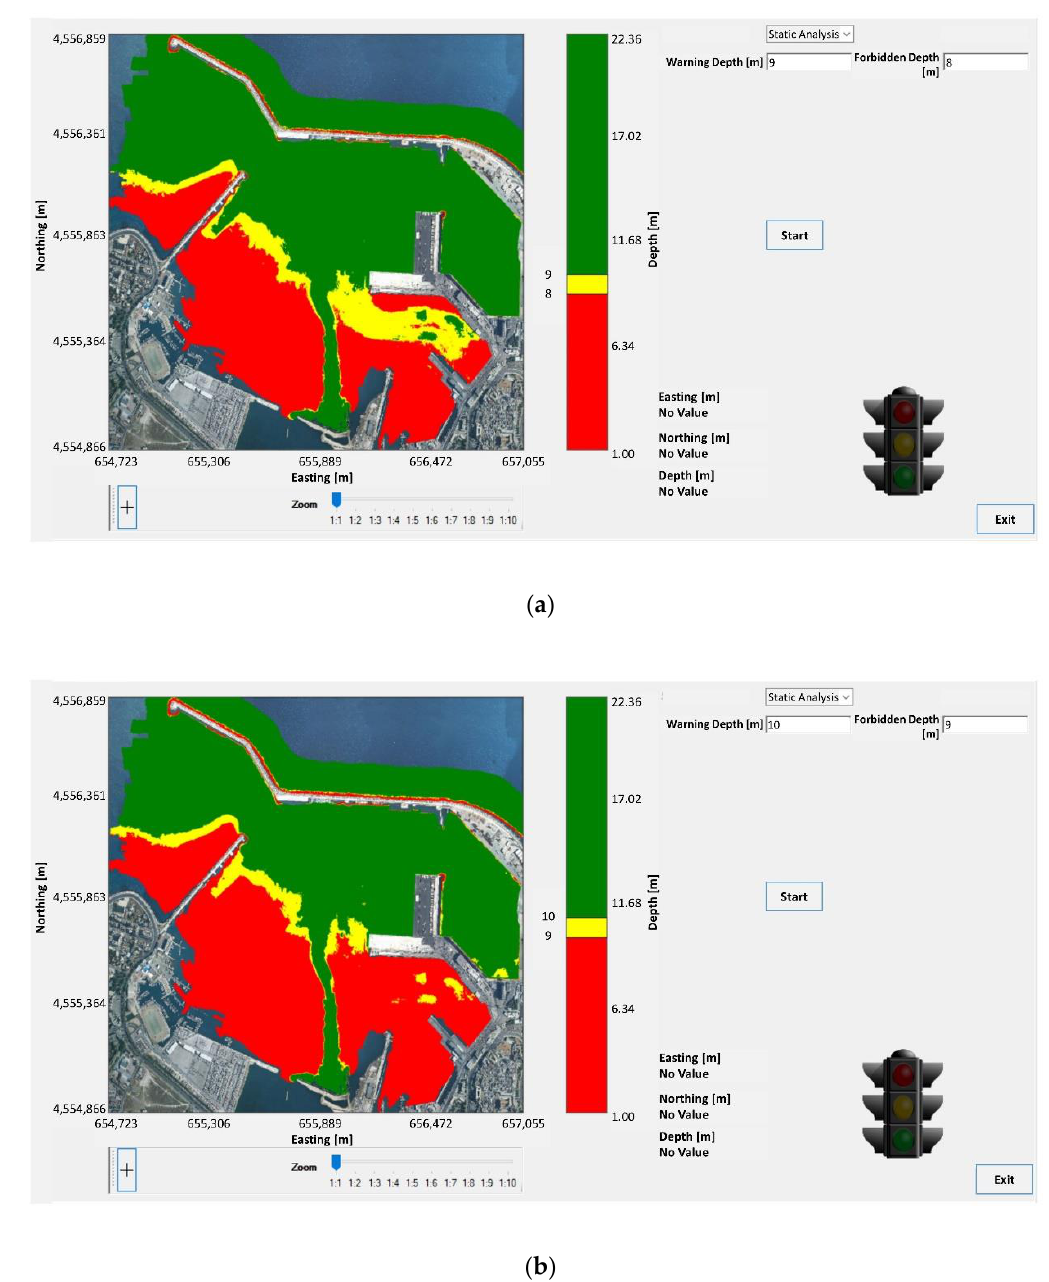
Figure 4. Virtual traffic lights in the port of Bari: ( a ) thresholds equal to 8 and 9 m; ( b ) thresholds equal to 9 and 10 m.